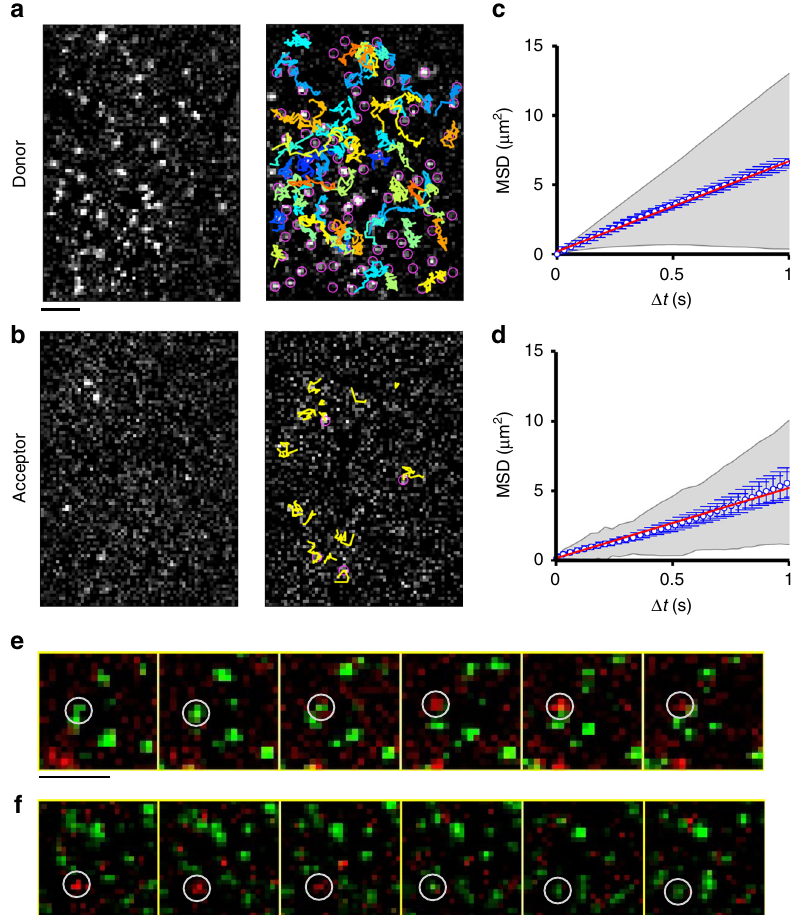
Fig. 1 Single-molecule FRET trajectories. FRET a donor and b acceptor single-molecule fl uorescence was imaged on a single camera. Single particles were detected and tracked in time. Images shown here following image processing (see Methods section). In the case of donor trajectories only a sub-fraction are overlaid for clarity. Scale bar: 5 μ m. Two-dimensional diffusion constants were determined for the c donor- and d acceptor-imaged particles: D donor (monomer) = 1.63 μ m 2 s − 1 (95% CI [1.609, 1.647] μ m 2 s − 1 , n = 17,853 trajectories); D acceptor (dimer) = 1.27 μ m 2 s − 1 (95% CI [1.222,1.317] μ m 2 s − 1 , n = 1167 trajectories). Data points represent weighted average at each delay interval over all trajectories. Grey shaded area represents the weighted standard deviation over all individual trajectory mean squared displacement (MSD) curves. Error bars represent standard error of the mean on each data point. e , f Sequential frames (30 ms per frame) of overlaid donor (green — Cy3) and acceptor (red — Cy5) channels show partial trajectories of monomeric and dimeric NTS1 species. Scale bar: 5 µ m. e Dimer formation: an initial population of Cy3-labelled monomeric NTS1 and dimeric Cy3- and Cy5-labelled NTS1 diffuse within the membrane. Between frames 3 and 4 a single Cy3-labelled receptor (encircled) switches from green to red indicative of the initiation of FRET as a result of dimer formation. See also Supplementary Movie 2. f Dimer termination of observation: a FRET capable NTS1 dimer comprised of Cy3- and Cy5-labelled receptor (encircled) is observed to diffuse in the membrane. Between frames 3 and 4 this spot switches from red to green as FRET is terminated, either as a result of receptor dissociation or acceptor photobleaching. See also Supplementary Movie